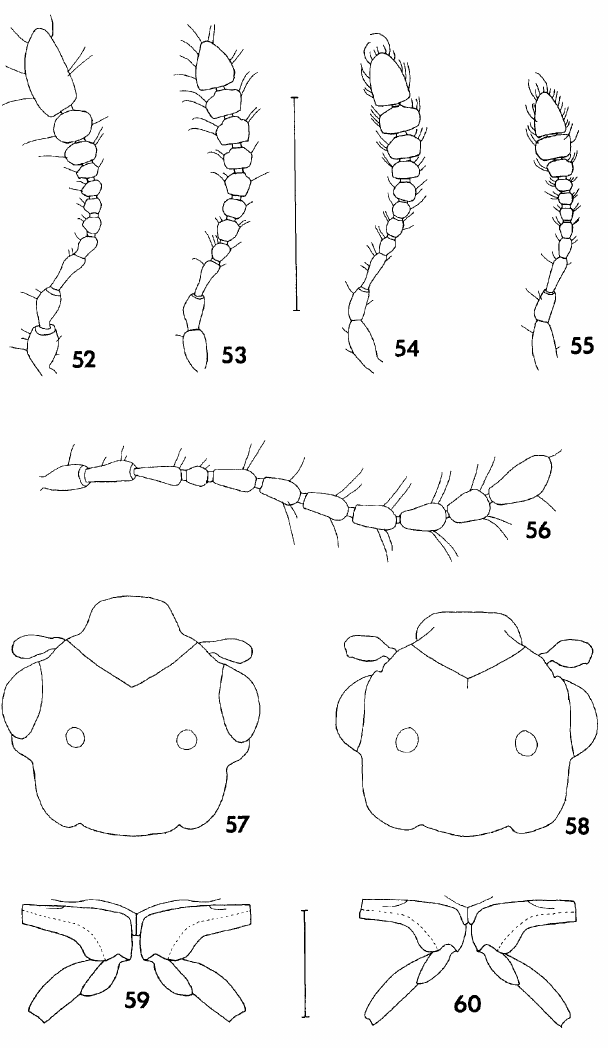
Figs. 52-60. Glypholoma spp. 52-56. Right antenna, dorsal view; 52, G. peck# 53, G. temporale; 54, G. pustuliferum; 55, G. rotundulum; 56, G. tenuicorne. 57-58. Head, dorsal view; 57, G. temporale; 58. G. pustuliferum. 59-60. Metacoxae and metasternal antecoxal sutures; 59, G. temporale; 60, G. pustuliferum. Scale lines 0.5 mm; upper one applies to figs. 52-58, lower one to figs.